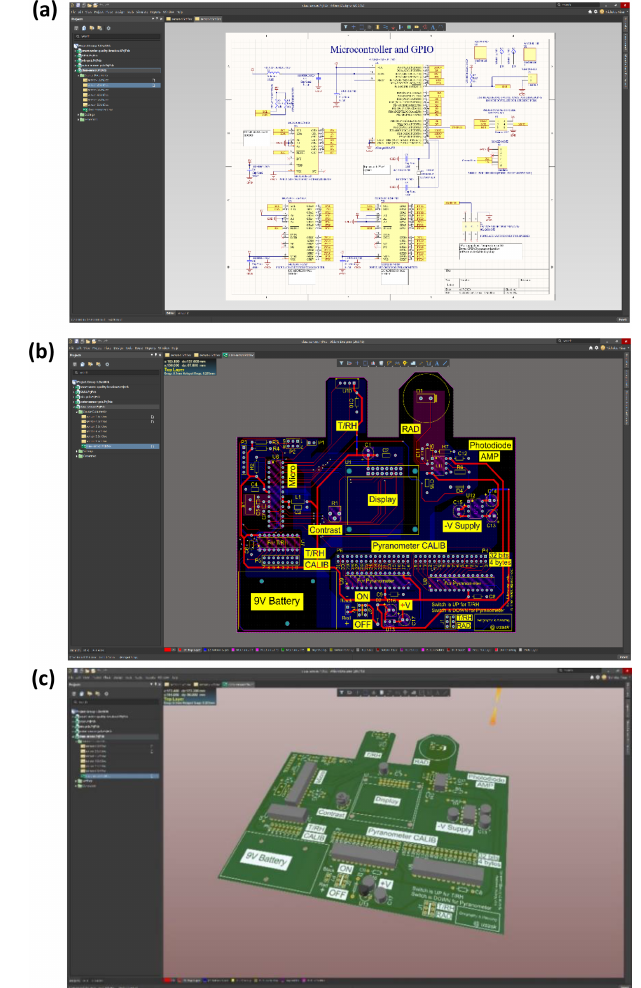
Figure 2. (a) Electronic layout software showing a schematic page of the hybrid temperature, relative humidity, and solar radiation sen- sor. (b) Associated PCB with layers stacked in a similar fashion to a geographic information system (GIS). (c) 3D model of the PCB generated using the layout software.